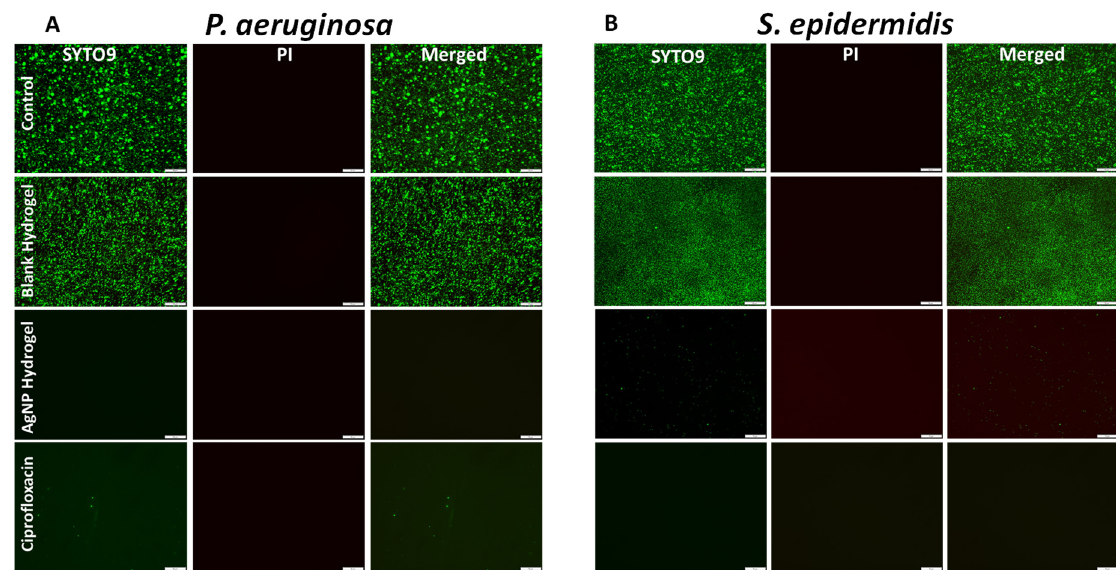
Figure 6. ( A , B ) Representative fluorescence microscopy images of P. aeruginosa (left panel) and S. epidermidis (right panel) stained with Live/Dead viability kit after 24 h of incubation with control, blank hydrogel, AgNPs loaded hydrogel, and Ciprofloxacin. Scale bar 50 µm.